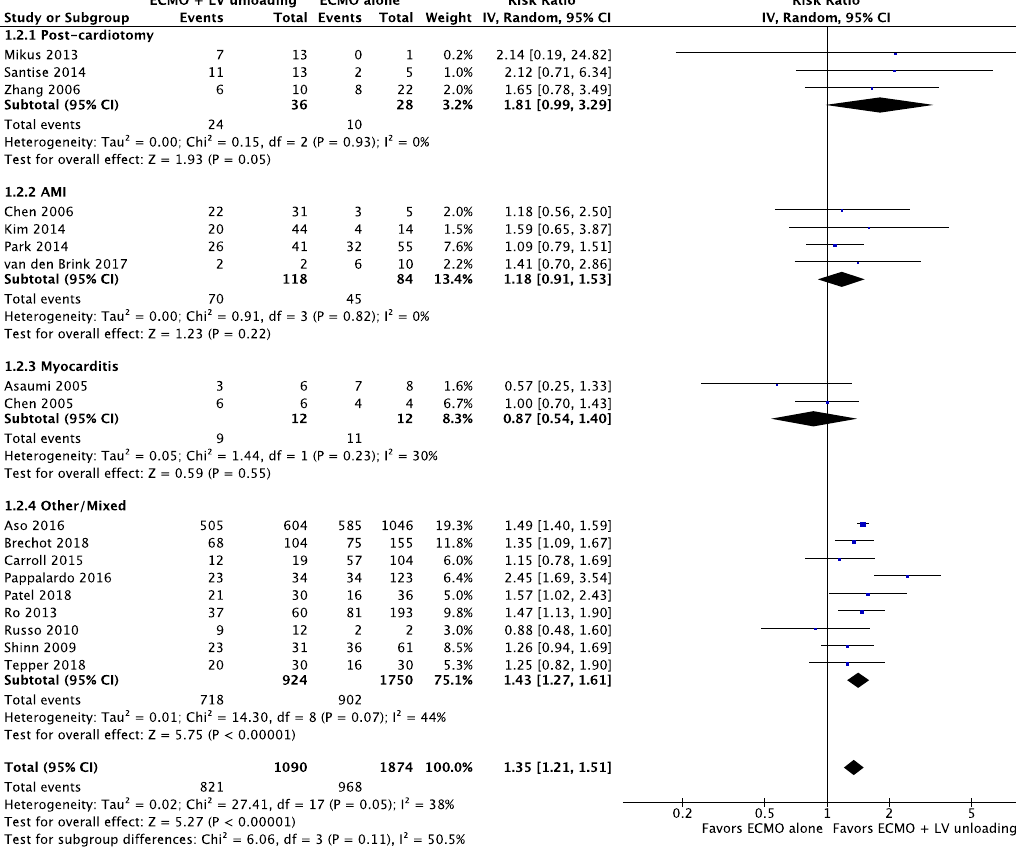
Figure 4. Weaning rate for patients receiving ECMO + LV unloading vs. ECMO alone treatment according to cardiogenic shock